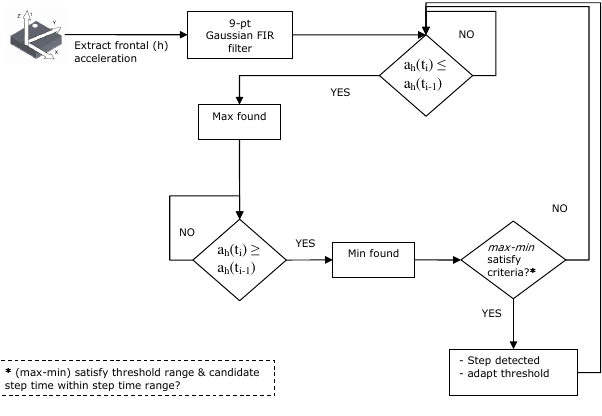
Fig. 4. Result of the Gaussian filtering of the data shown in Figure